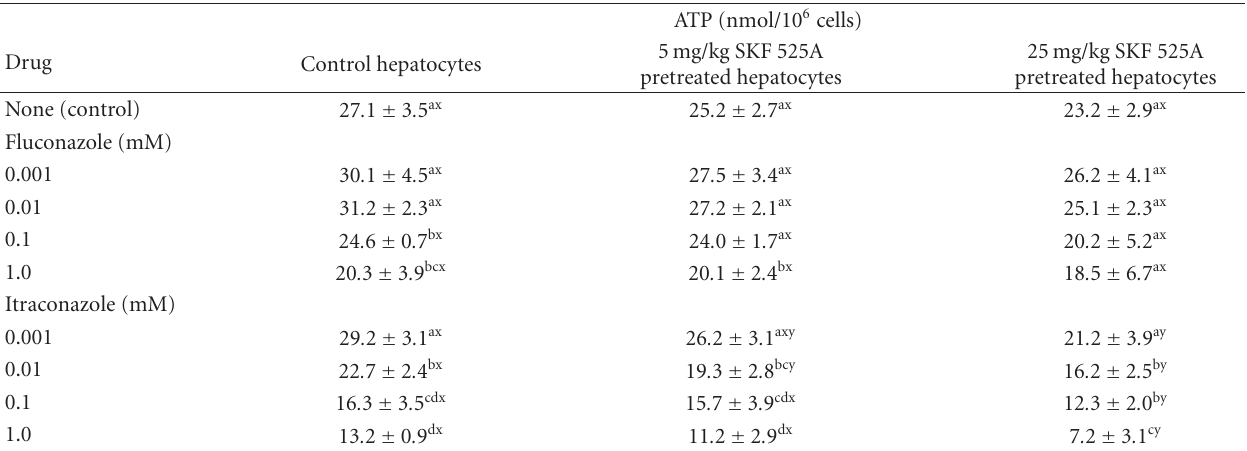
Figure 2: E ff ects of Cytochrome P450 inhibitors on the percentage viability of hepatocytes. ∗ Significant di ff erent ( P < . 05) when compared to controls. Values are mean ± sd of 3 separate experiments. Table 1: ATP levels in rats hepatocytes after fluconazole or itraconazole incubations. Control and SKF 525A pretreated hepatocytes were exposed to various concentrations of fluconazole or itraconazole for 6